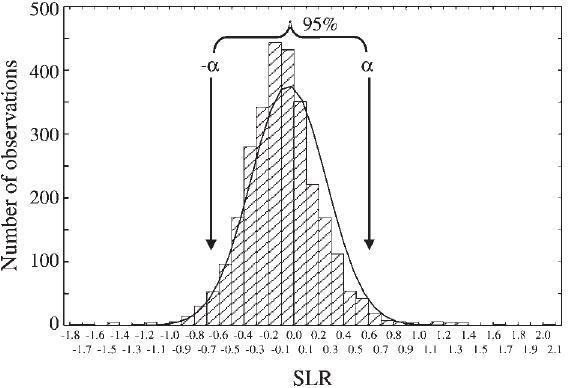
Figure 3 - Illustration of how the 95% confidence threshold ( α ) is deter- mined. Signal intensity group of 400 < x ≤ 800 in one representative